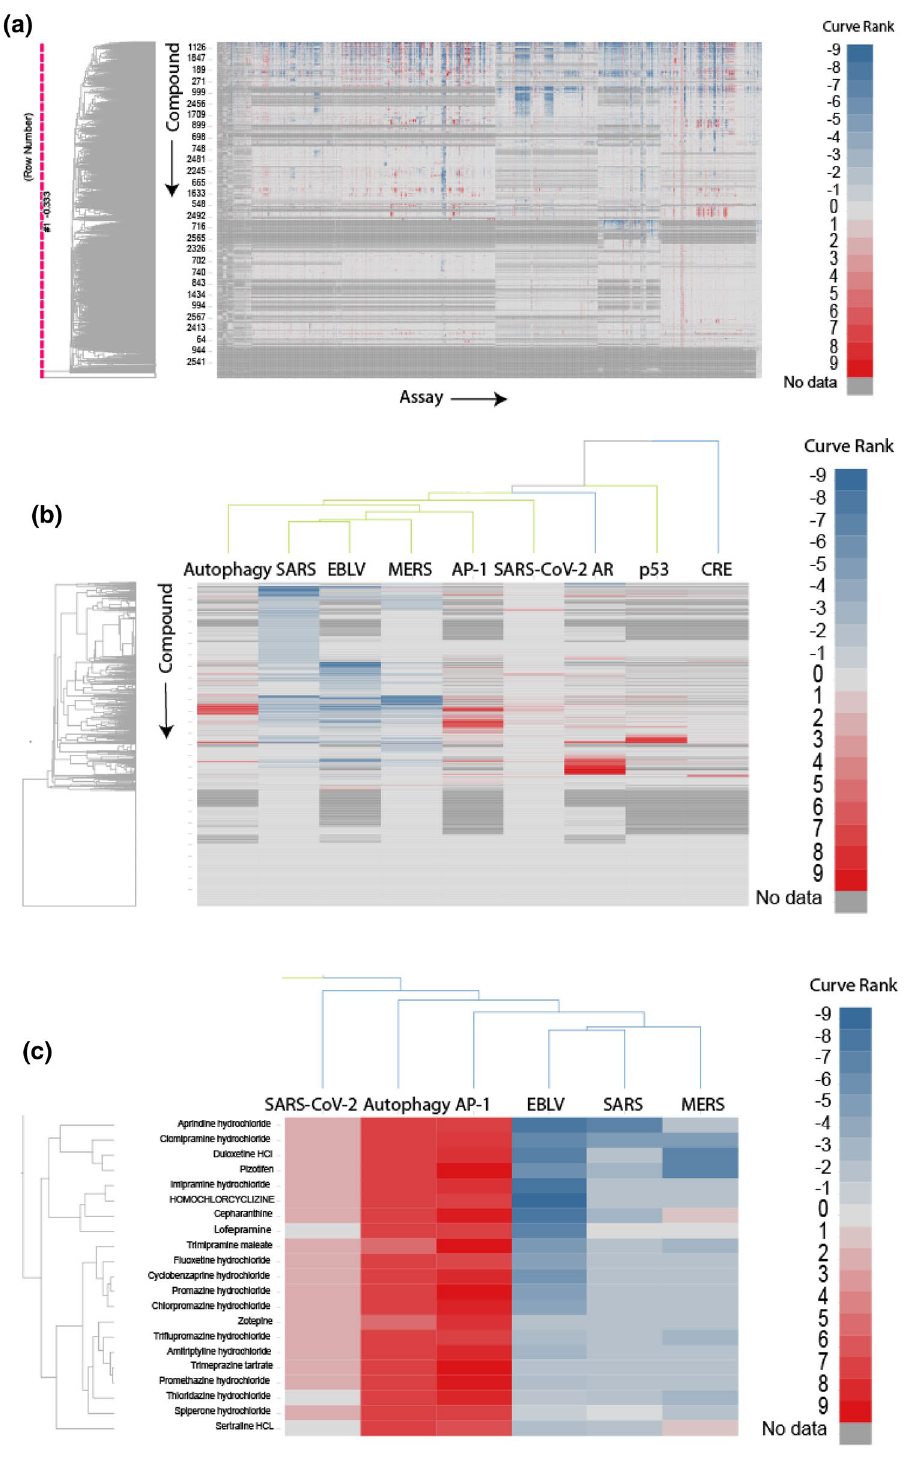
Figure 1. Compound activity profiles from the ~ 1000 NPC screens. In the heat map, each row is a compound, and each column is an assay. The heat map is colored by “curve rank” 26,27 , a numeric measure (between -9 and 9) of compound activity based on potency, efficacy, and the quality of the concentration response curve, such that a large positive number indicates a strong activator (red), i.e., a compound that activates or induces the assay target activity, a large negative number indicates a strong inhibitor (blue), i.e., a compound that inhibits the assay target activity, and 0 means inactive (light gray). Dark gray indicates missing data. ( a ) All assays. ( b ) Examples of assays that showed significant correlations with the SARS-CoV-2 CPE assay (SARS-CoV, MERS, EBLV, autophagy, AP-1) and assays that showed no correlation with the SARS-CoV-2 CPE assay (p53; AR androgen receptor; CRE cAMP response element). ( c ) A zoomed-in view that shows the activities of a group of mostly psychoactive drugs that were active in the SARS-CoV-2 CPE assay as well as the autophagy and/or AP-1